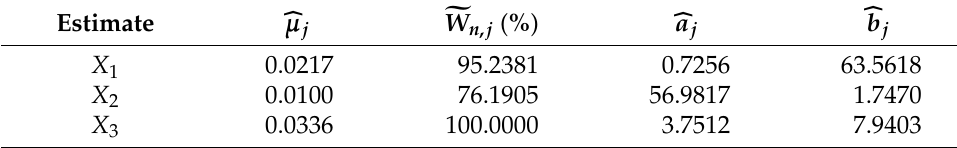
Table 4. Parameter estimates of models and diagnostic percents of univariate